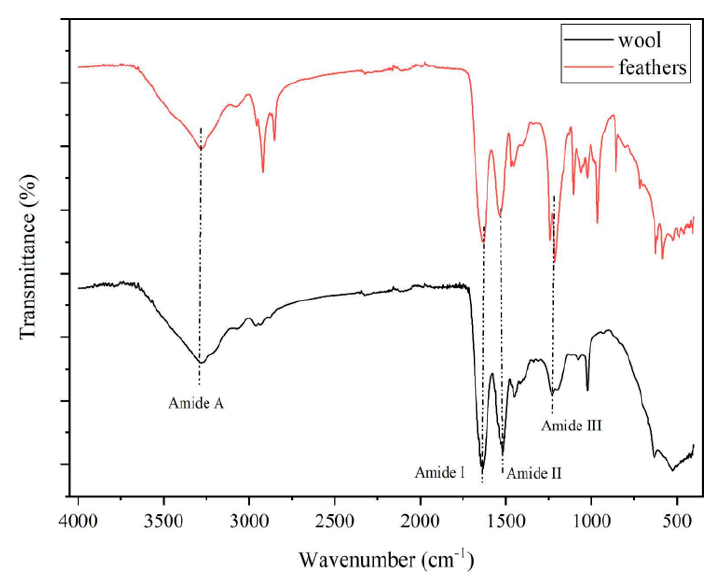
Figure 9. Comparison between the IR spectrum of keratin extracted from wool (in black) and the spectrum of keratin extracted from feathers (in red).